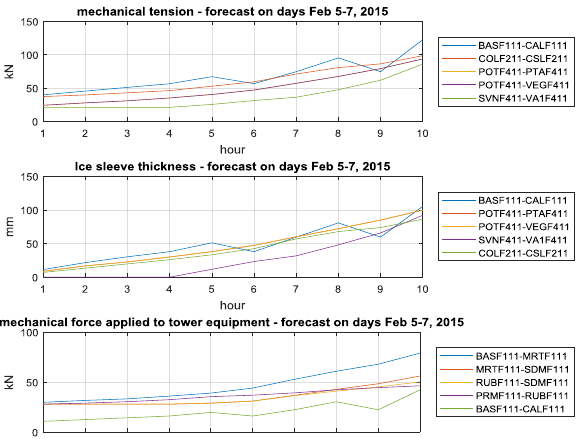
Table 2. Summary of simulation scenarios and their